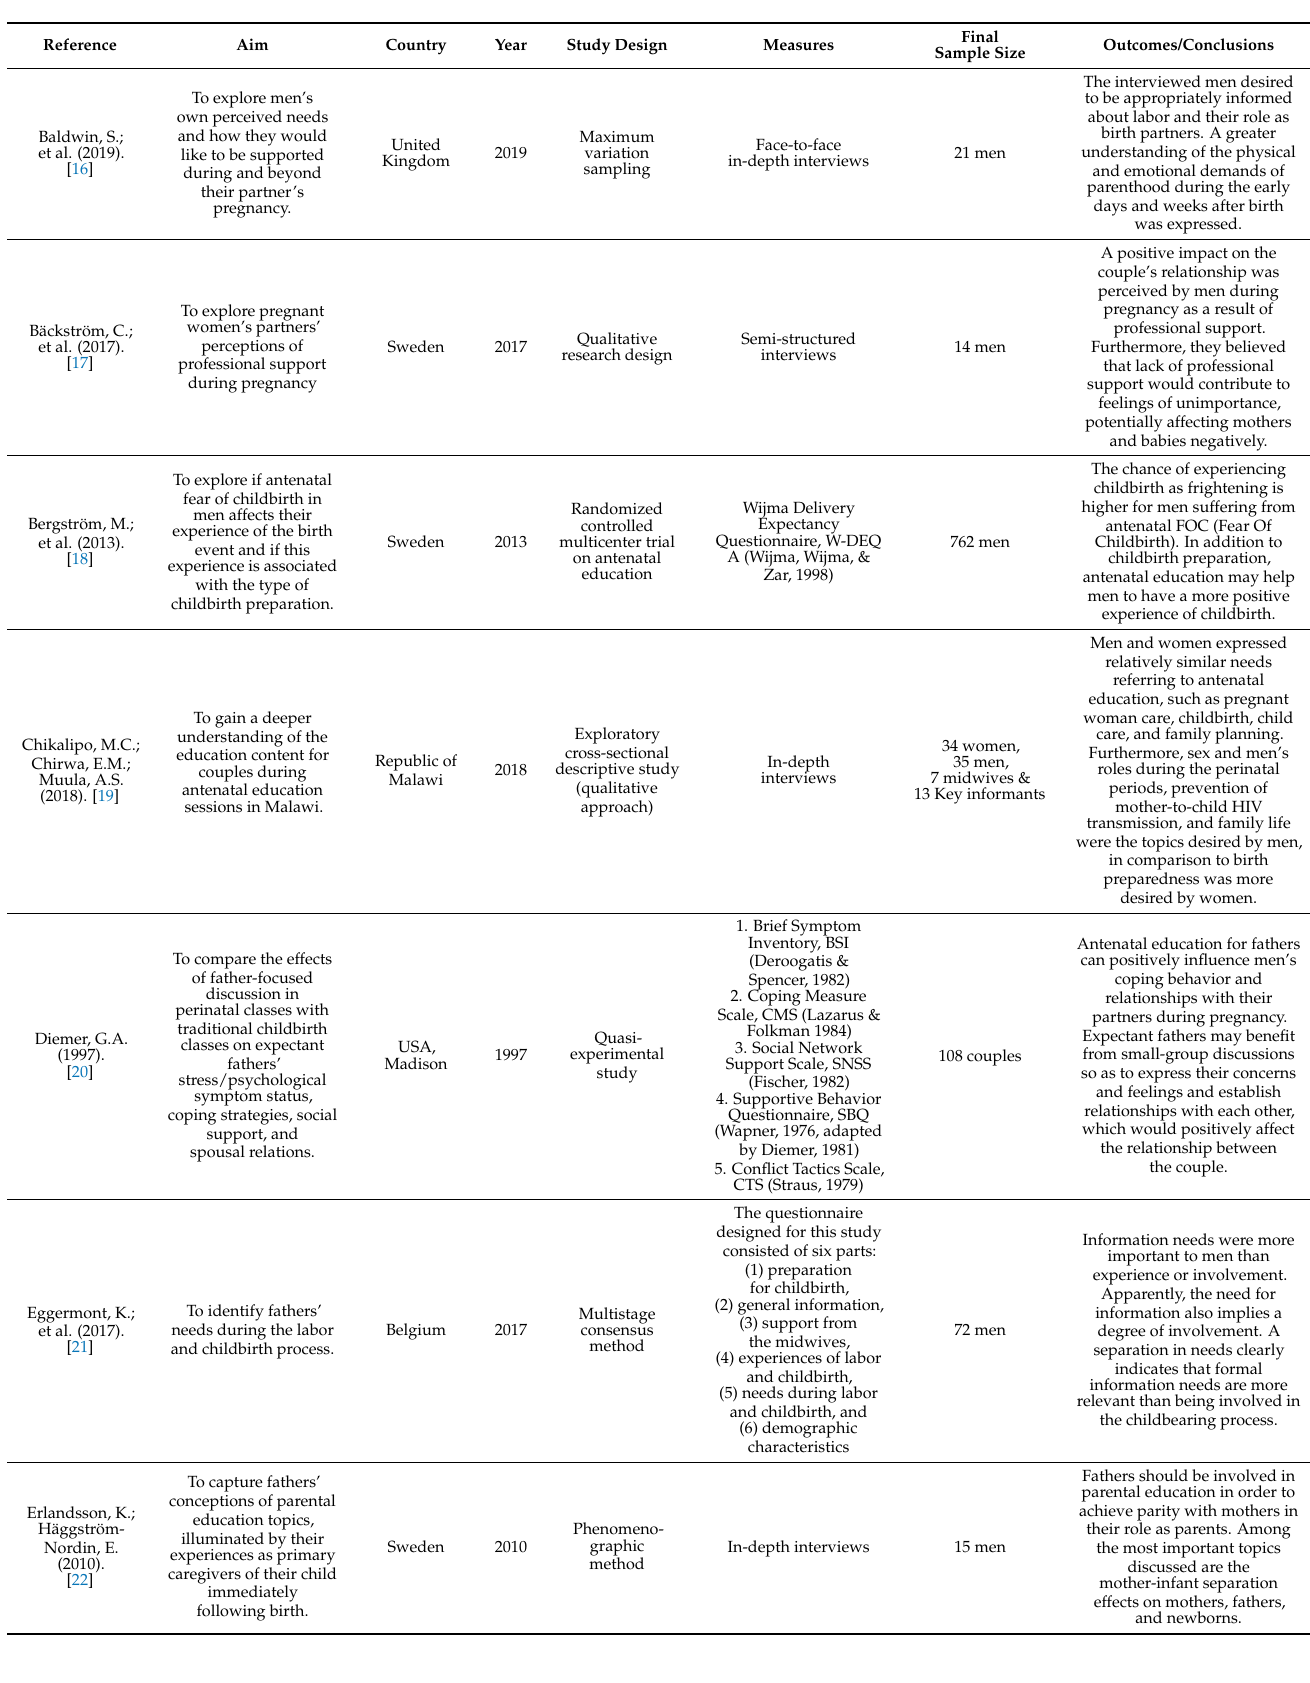
Table 1. Characteristics of included